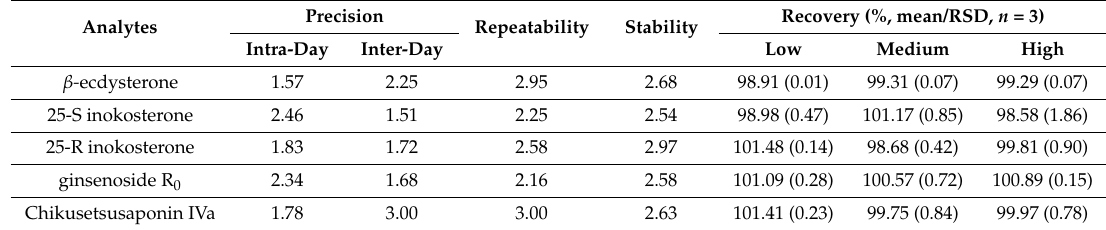
Table 3. Precision, repeatability, stability, and recovery of the five investigated analytes (overall intra-day and inter-day variations (RSD), %, n =